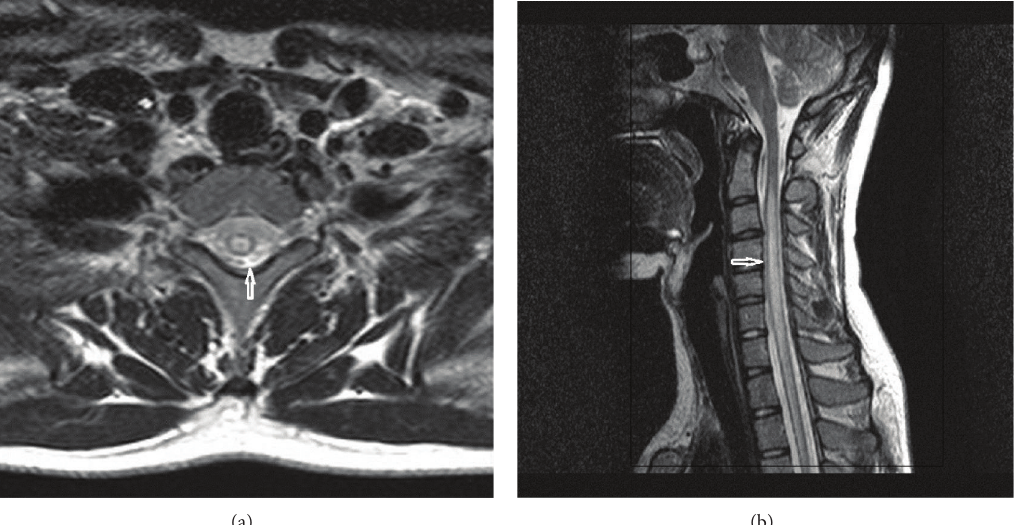
Figure 1: T2-weighted axial (a) and sagittal (b) MR images of the cervical spine demonstrate long segmental intramedullary high signal intensity suggesting transverse